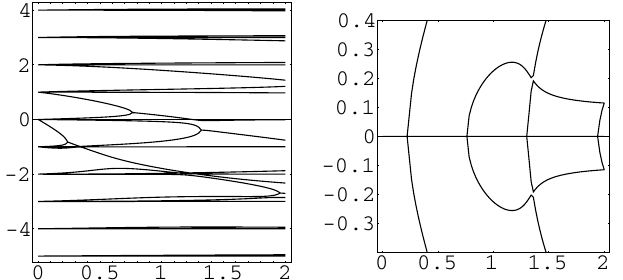
FIG. 67. Real and imaginary part of the coherent tune shift in units of the synchrotron tune without incoherent tune shift versus the electron density in units of 10 12 m (cid:2) 3 for a bunch of N 10 11 protons in the SPS, computed by Perevedentsev